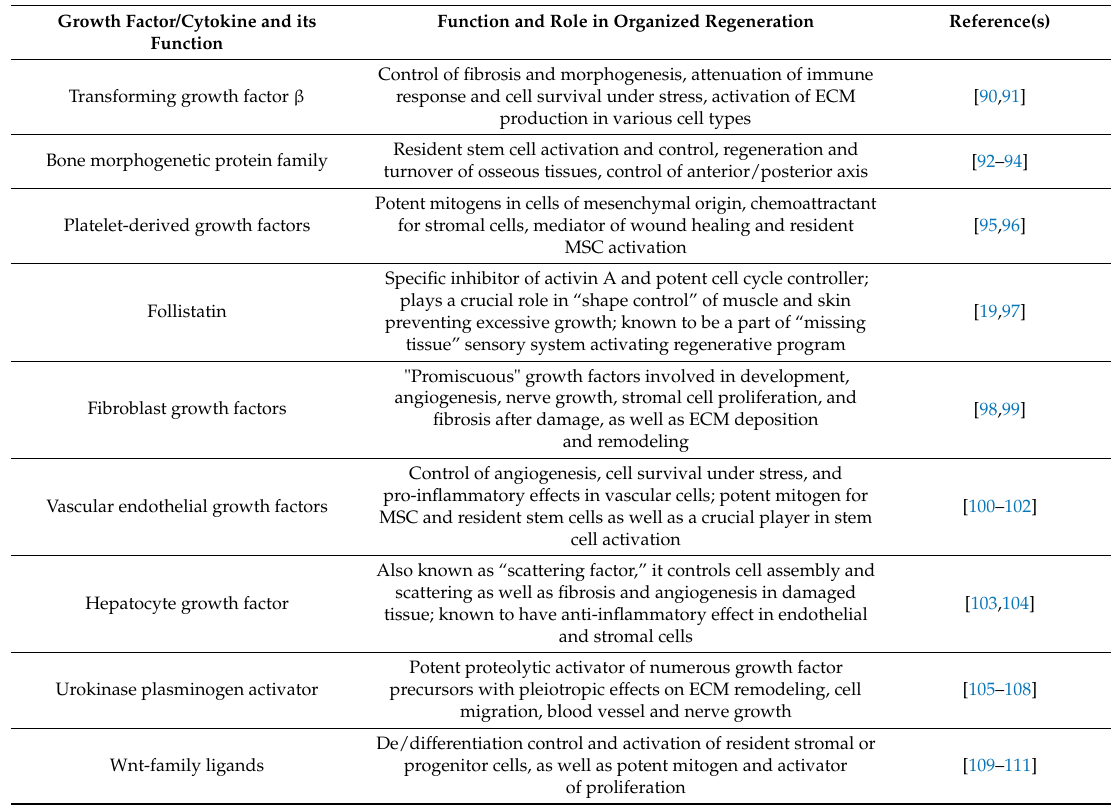
Table 2. Paracrine factors produced by MSCs that may play a role in their self-organization and/or their guiding role in regeneration Growth Factor/Cytokine and its